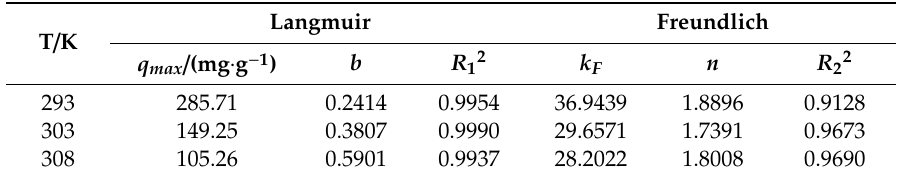
Figure 7. Fitting curve of Langmuir ( a ) and Freundlich ( b ) isothermal adsorption model of U(VI) adsorption by CMC/P-(NIPAM-co-AA). Table 7. Langmuir and Freundlich isothermal adsorption model parameters of U(VI) adsorption by CMC/P (NIPAM-co-AA).